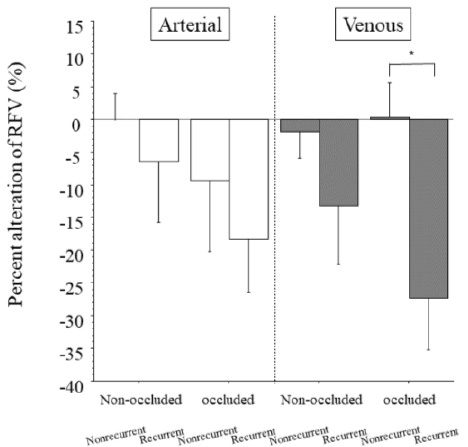
Figure 4. Percent change in relative blood volume between patients with and without recurrent macular edema. We found no significant differences between the nonrecurrent and recurrent groups in the percent change in RFV in the arteries of the non-occluded and occluded regions ( p = 0.525, p = 0.512, respectively). We found no significant difference in the percent alteration in RFV between the nonrecurrent and recurrent groups in the veins of the non-occluded region ( p = 0.251), but we did find a significant difference in the percent alteration in RFV between the groups in the veins of the occluded region (* p = 0.005). Table 3. Aqueous humor levels of factors/cytokines and the aqueous flare value at